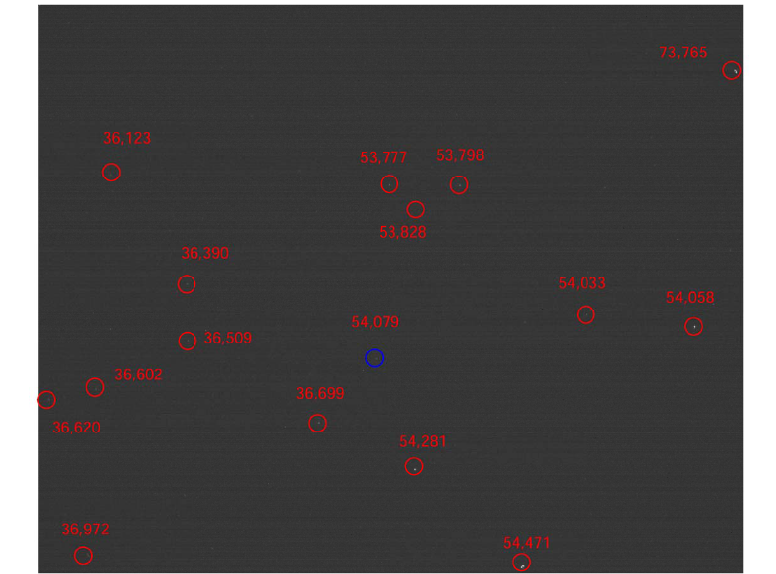
Figure 9. The real star